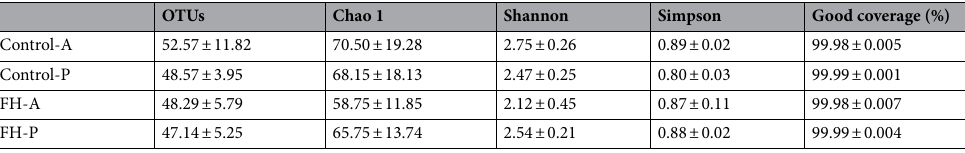
Table 2. Number of OTUs and alpha diversity indexes of bacterial communities in the anterior (A) and posterior (P) intestinal sections of S. aurata fed with control (Control) and N. gaditana (FH) diets. Mean values and standard deviation were